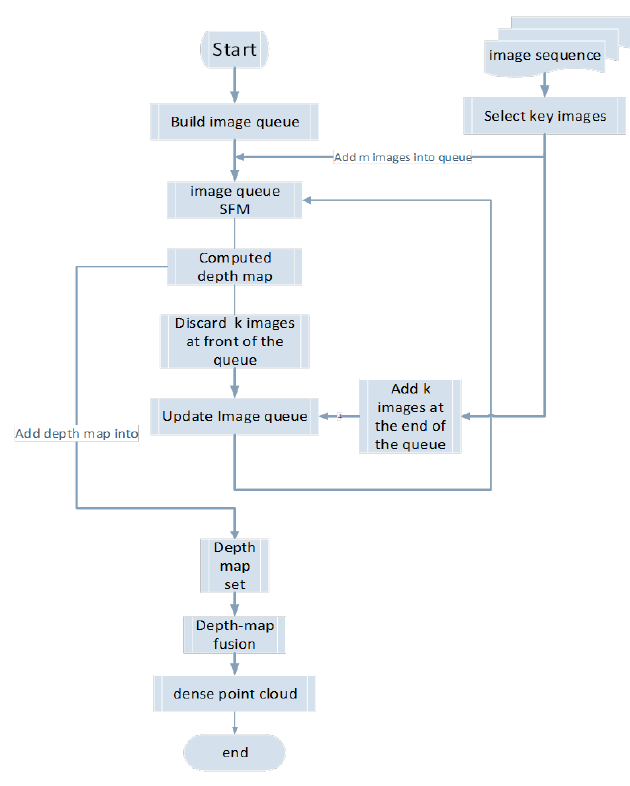
Figure 1. Algorithm flowchart.